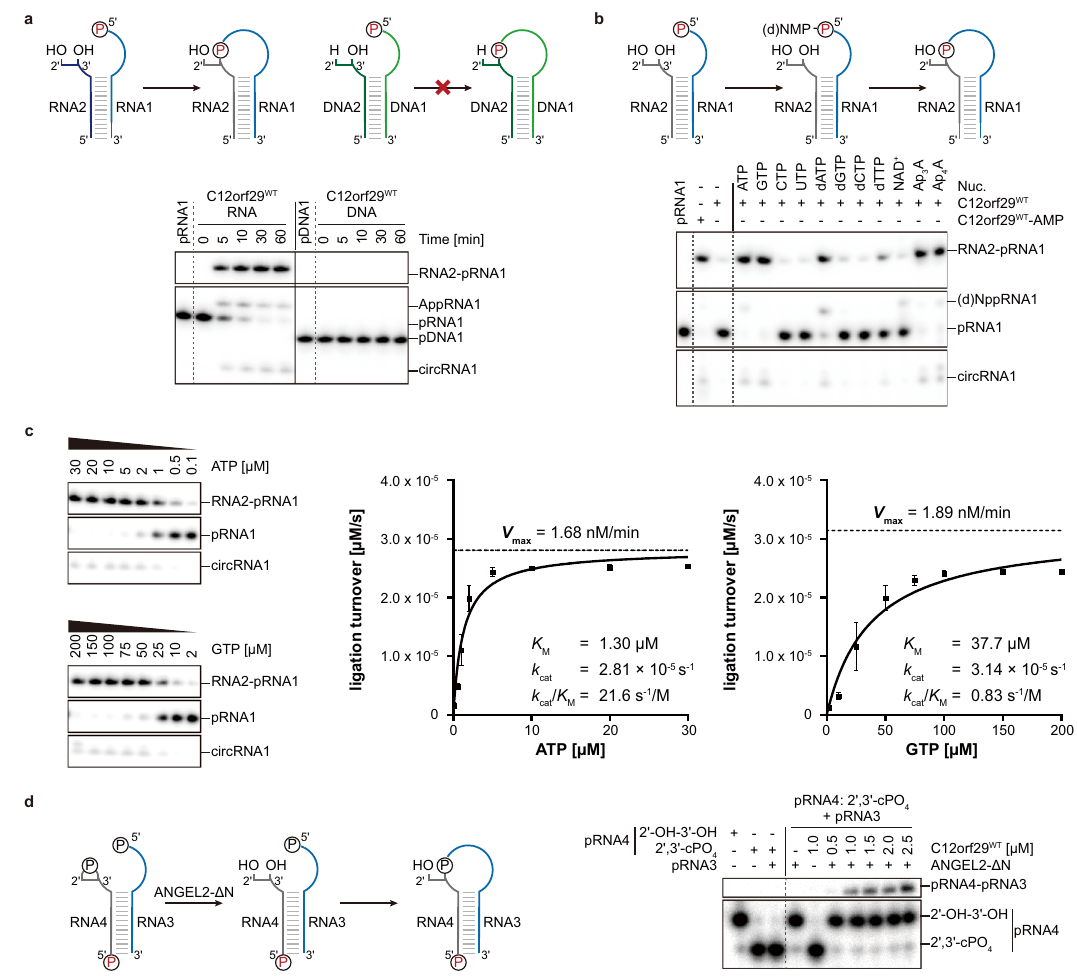
Fig. 3 | RNA ligase activity of C12orf29. RNA/DNA oligonucleotides are schema- tically depictedinblue/green, respectively. The 32 P-labelled 5 ′ -endsare depictedin red. The radioactive oligonucleotides were resolved by denaturing PAGE and ana- lysed by phosphorimaging. a (Top) Schematic display of two nucleic acid sub- strates used. (Bottom) PAGE analysis of reaction products after incubation with C12orf29 for various time points as indicated. Ligation was observed for 5 ′ -phos- phorylated RNA (representative images of n =3). b Reaction of C12orf29 with indicated RNA constructs using various nucleotides (representative images of n =3). Besides ATP, C12orf29 is able to ef fi ciently catalyse ligation by processing